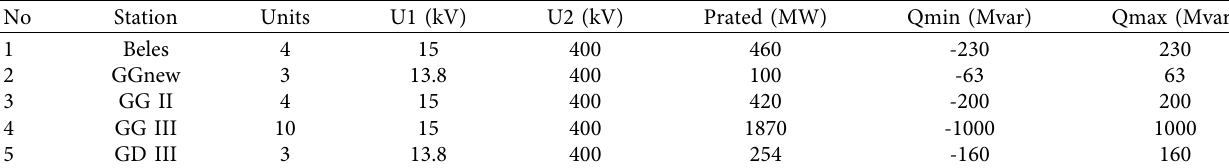
Table 1: Existing ICS 400 kV rated hydropower plants.